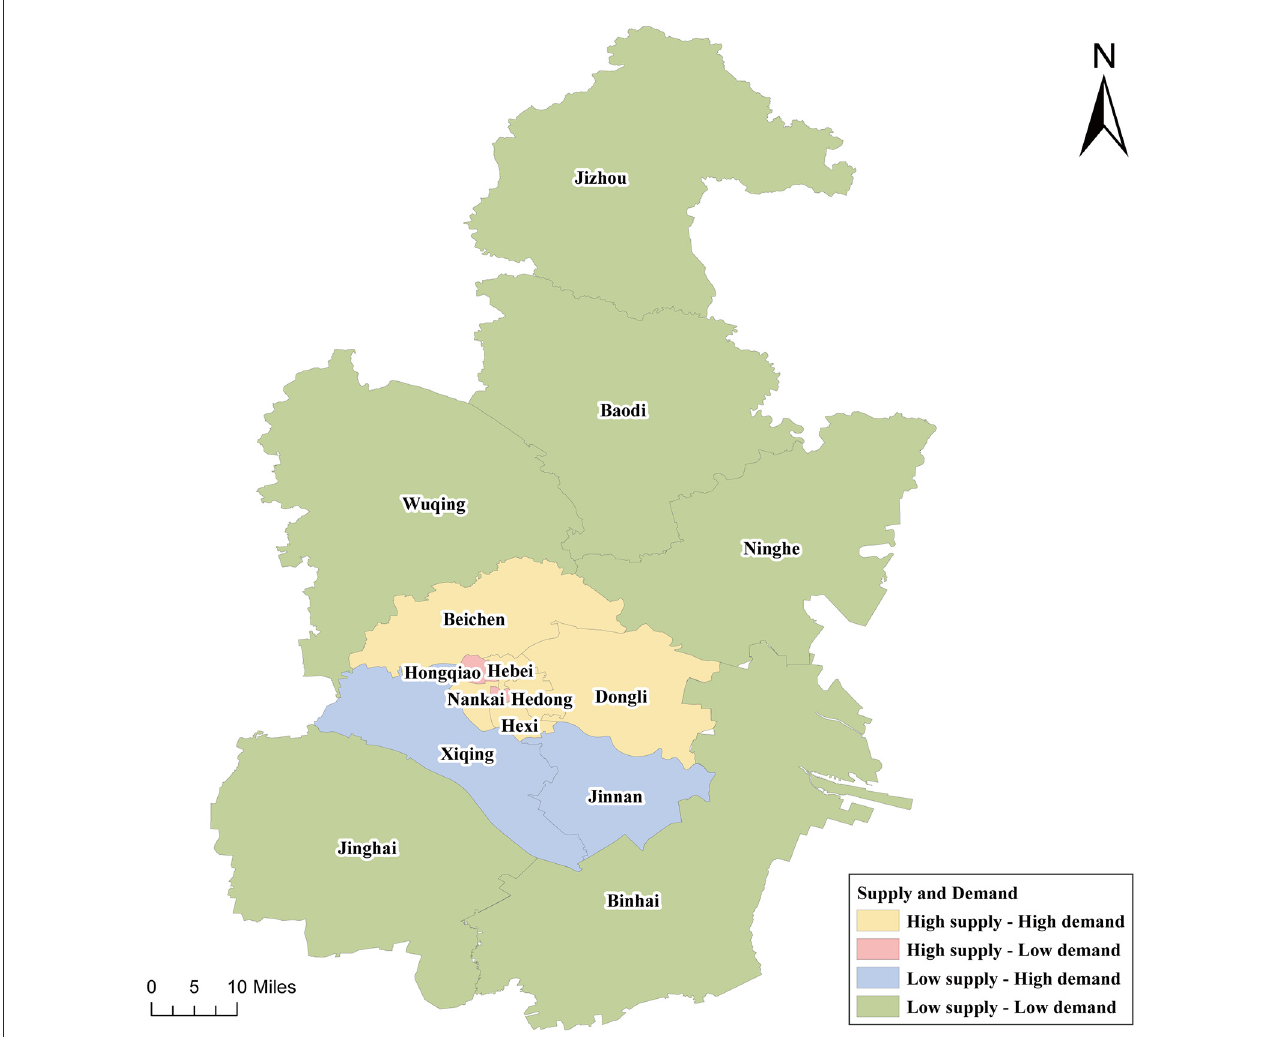
FIGURE5 Supply–demand matching pattern of EMS at different levels in Tianjin. Urban areas include Heping, Hexi, Hedong, Nankai, Hebei, and Hongqiao districts. Sub-urban areas include Dongli, Xiqing, Jinnan, and Beichen districts. Rural areas include Baodi, Wuqing, Ninghe, Jinghai, Jixian, and Binhai